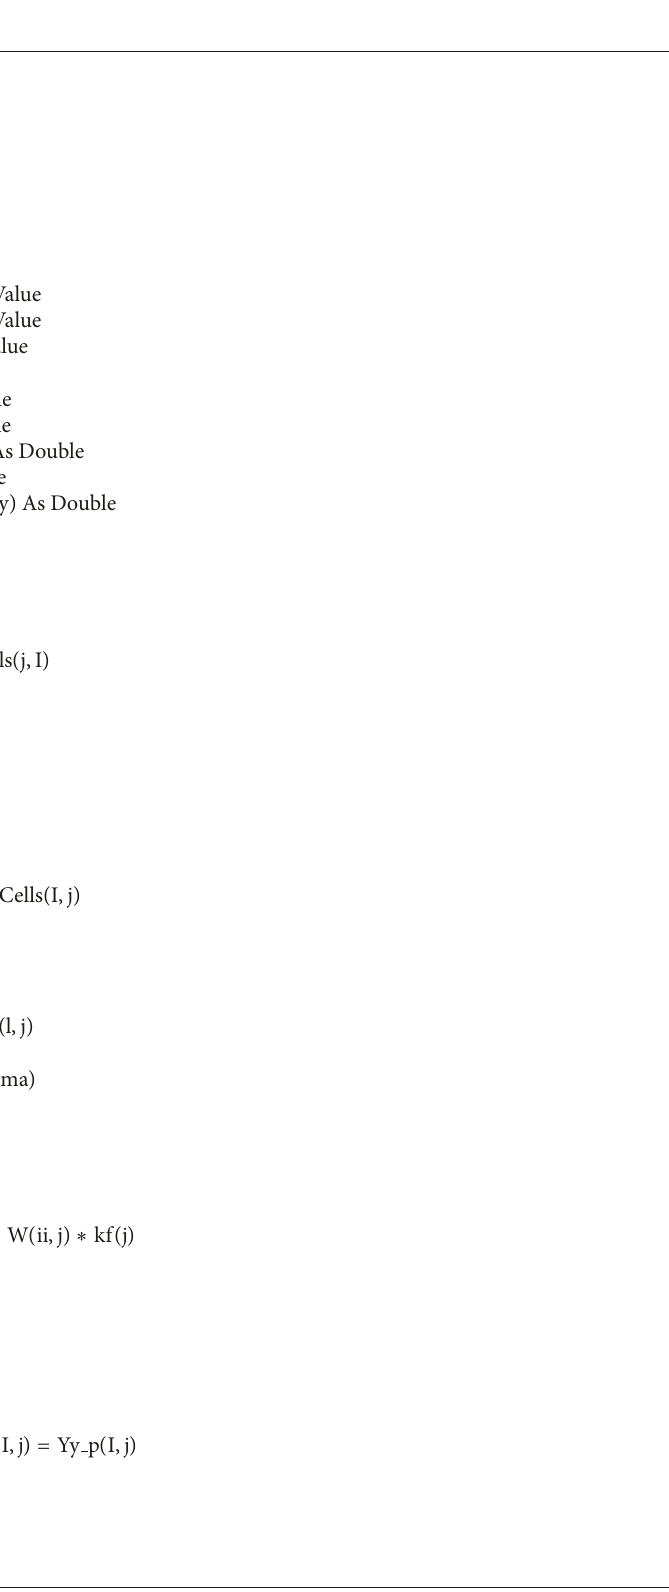
Algorithm 1: The code of